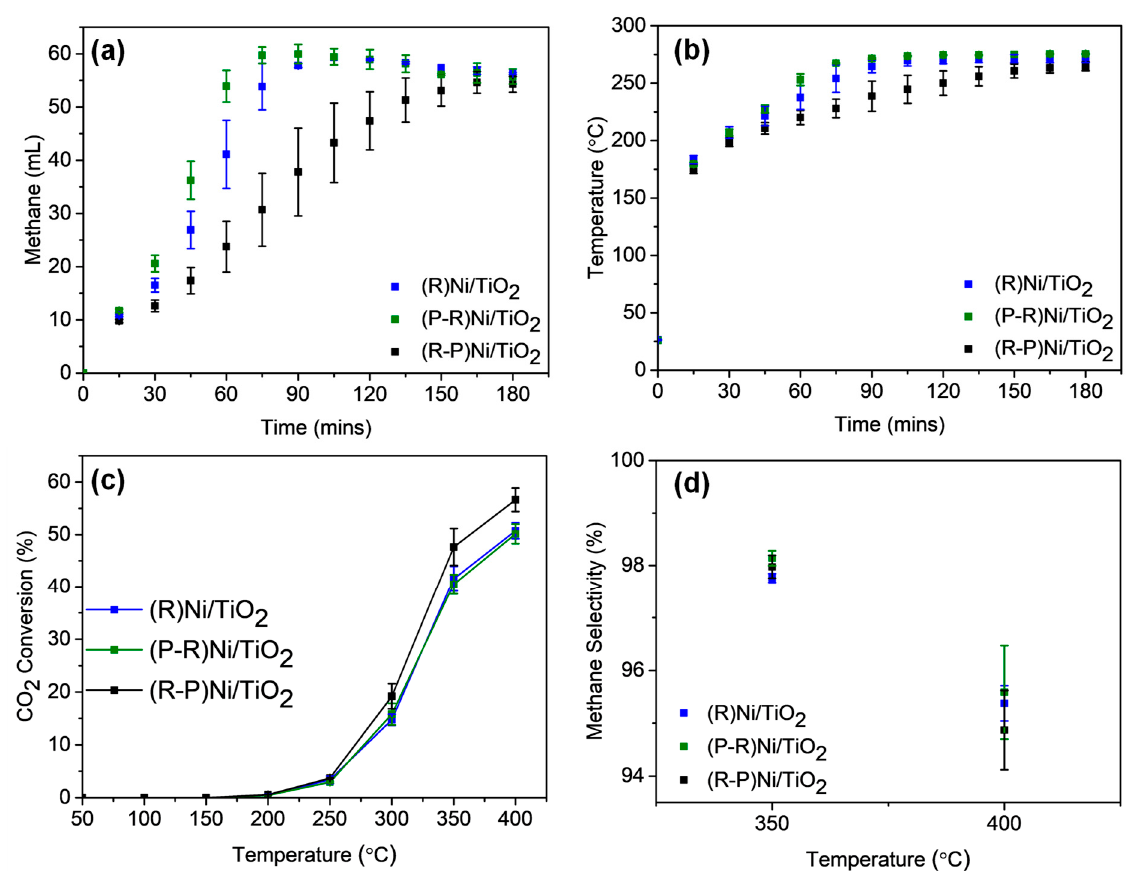
Figure 5. The influence of Ni/TiO 2 catalyst pretreatment on ( a ) methane formation and ( b ) the temperature profile during photothermal CO 2 methanation in a batch-circulated reactor system. Catalyst loading = 100 mg; Initial reactant pressure = ~15 kPa CO 2 and ~60 kPa H 2 ; illumination provided by a 300 W Xenon lamp. The influence of Ni/TiO 2 catalyst pretreatment on ( c ) CO 2 conversion and ( d ) methane selectivity during decoupled photo-and-thermal CO 2 methanation in a continuous flow reactor system. Catalyst loading = 100 mg; reacting gas flow rate = 4 mL/min CO 2 and 16 mL/min H 2 ; illumination provided by a 300 W Xenon lamp. Thermal only reaction indicated by the fi lled markers ( ● ). R = reduced/passivated, P = plasma treated.